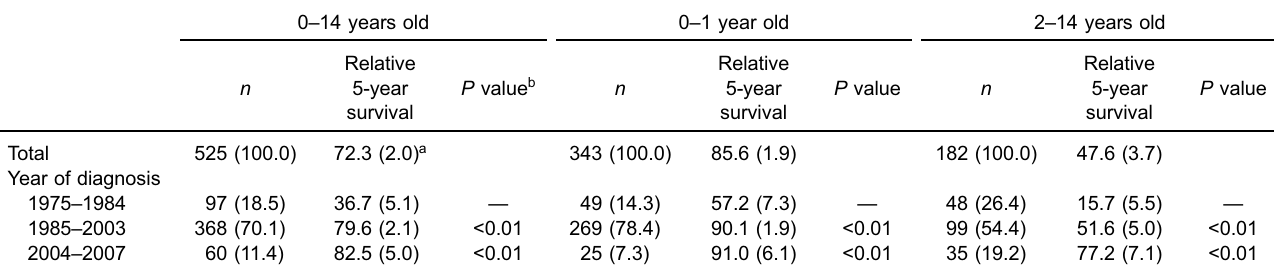
Table 3. Relative 5-year survival for neuroblastoma cases